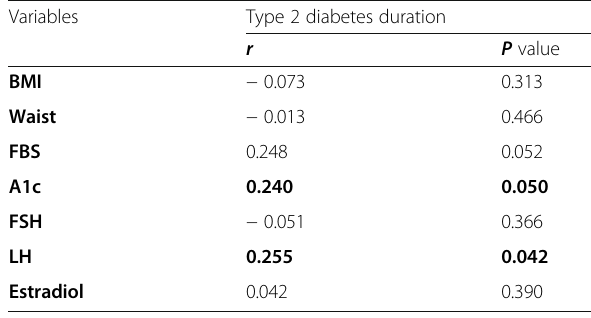
Table 5 Comparison of some physiological parameters between type 2 diabetic patients and control subject Indices